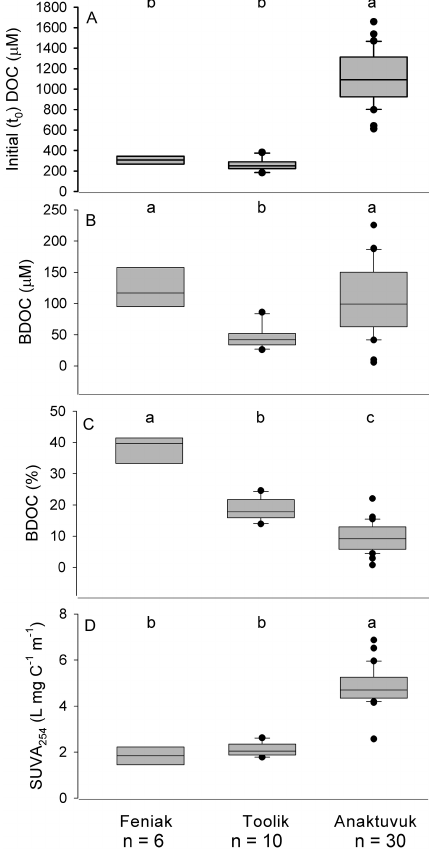
Figure 3. Assessing the impact of region (regardless of treatment) on stream DOC quantity (a) ; Biodegradability in terms of absolute loss (b) and percent loss (c) after 40 days; and SUVA 254 (d) . Box plots represent median, quartiles, minimum, and maximum within 1.5 times the interquartile range (IQR), and outliers beyond 1.5 IQR. Sample size ( n ) represents a sampling of a stream on a given day. The “Feniak” group represents 6 stream reaches sampled one time in the Feniak region. The “Toolik” group represents 2 stream reaches sampled 5 times over the season. The “Anaktuvuk” group represents 6 burned stream reaches sampled 4–5 times plus the 2 unburned sites sampled once. Different letters represent significant differences between regions, α =